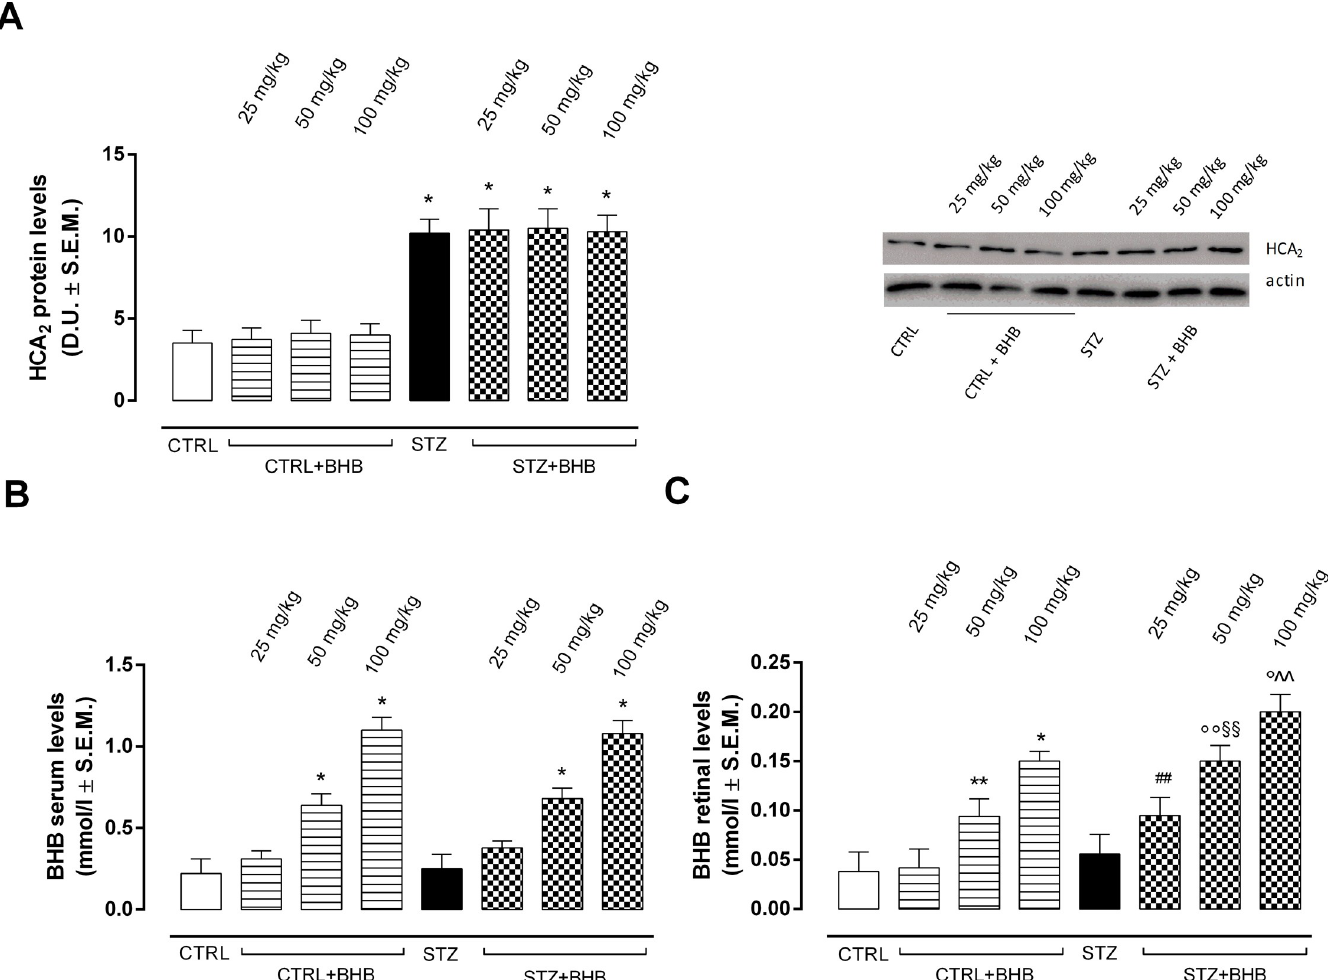
Fig 1. Retinal HCA 2 receptor protein and BHB levels in serum and retina. (A) Detection of retinal HCA 2 receptor protein levels by Western blot assay; (B) Determination of serum BHB levels and (C) retina BHB levels by ELISA. Values are expressed as the mean of 10 observations ± S.E.M. CTRL = nondiabetic mice; STZ = diabetic mice; STZ+BHB = diabetic mice receiving BHB. D.U. = Densitometric Units; � P < 0.01 vs CTRL; ˚˚P < 0.05 vs STZ; ˚P < 0.01 vs STZ; ## P < 0.05 vs CTRL+BHB 25; §§ P < 0.05 vs CTRL+BHB 50; ^^ P < 0.05 vs CTRL+BHB 100.